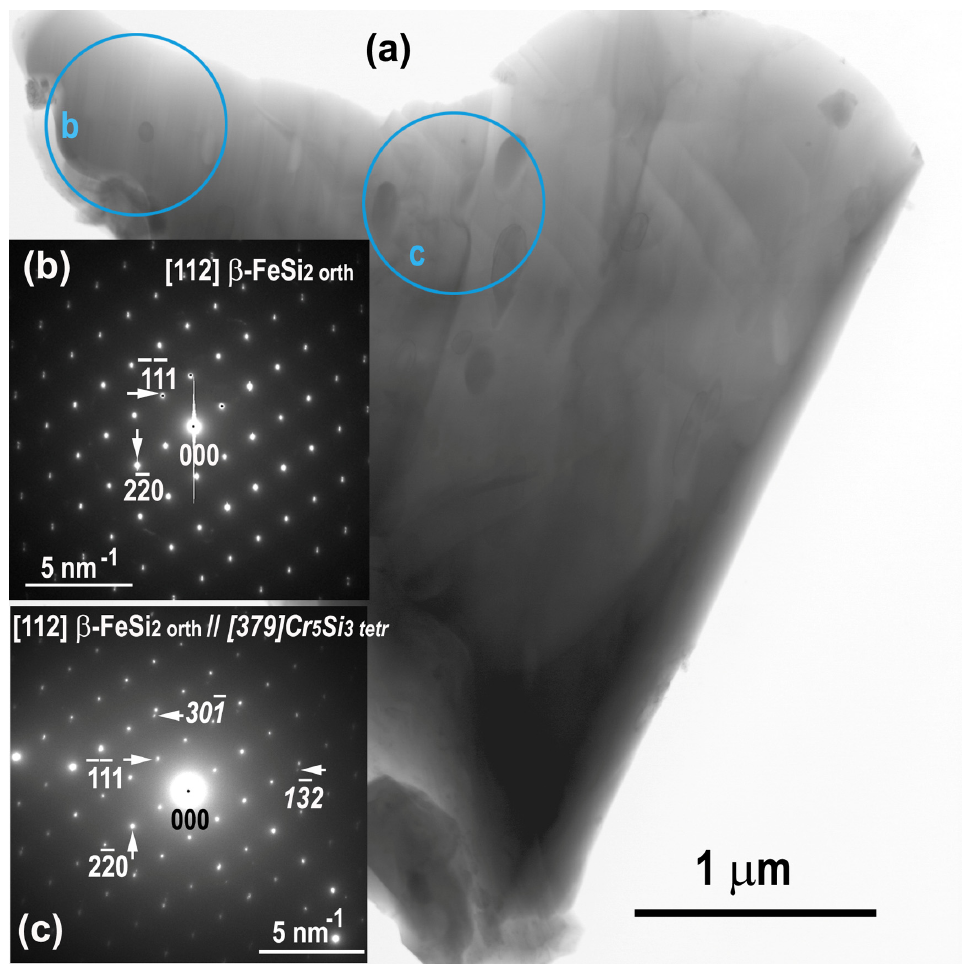
Figure 8. Annealed sample: BF STEM image ( a ); SAED pattern obtained from the [112] β− FeSi 2 orth directions ( b ); SAED pattern obtained from the β− FeSi 2 orth along the [112] direction and Cr 5 Si 3 nanoprecipitates along the [379] direction (Miller indexes are in regular or italic characters for FeSi 2 Cr 5 Si 3 , respectively ( c ).